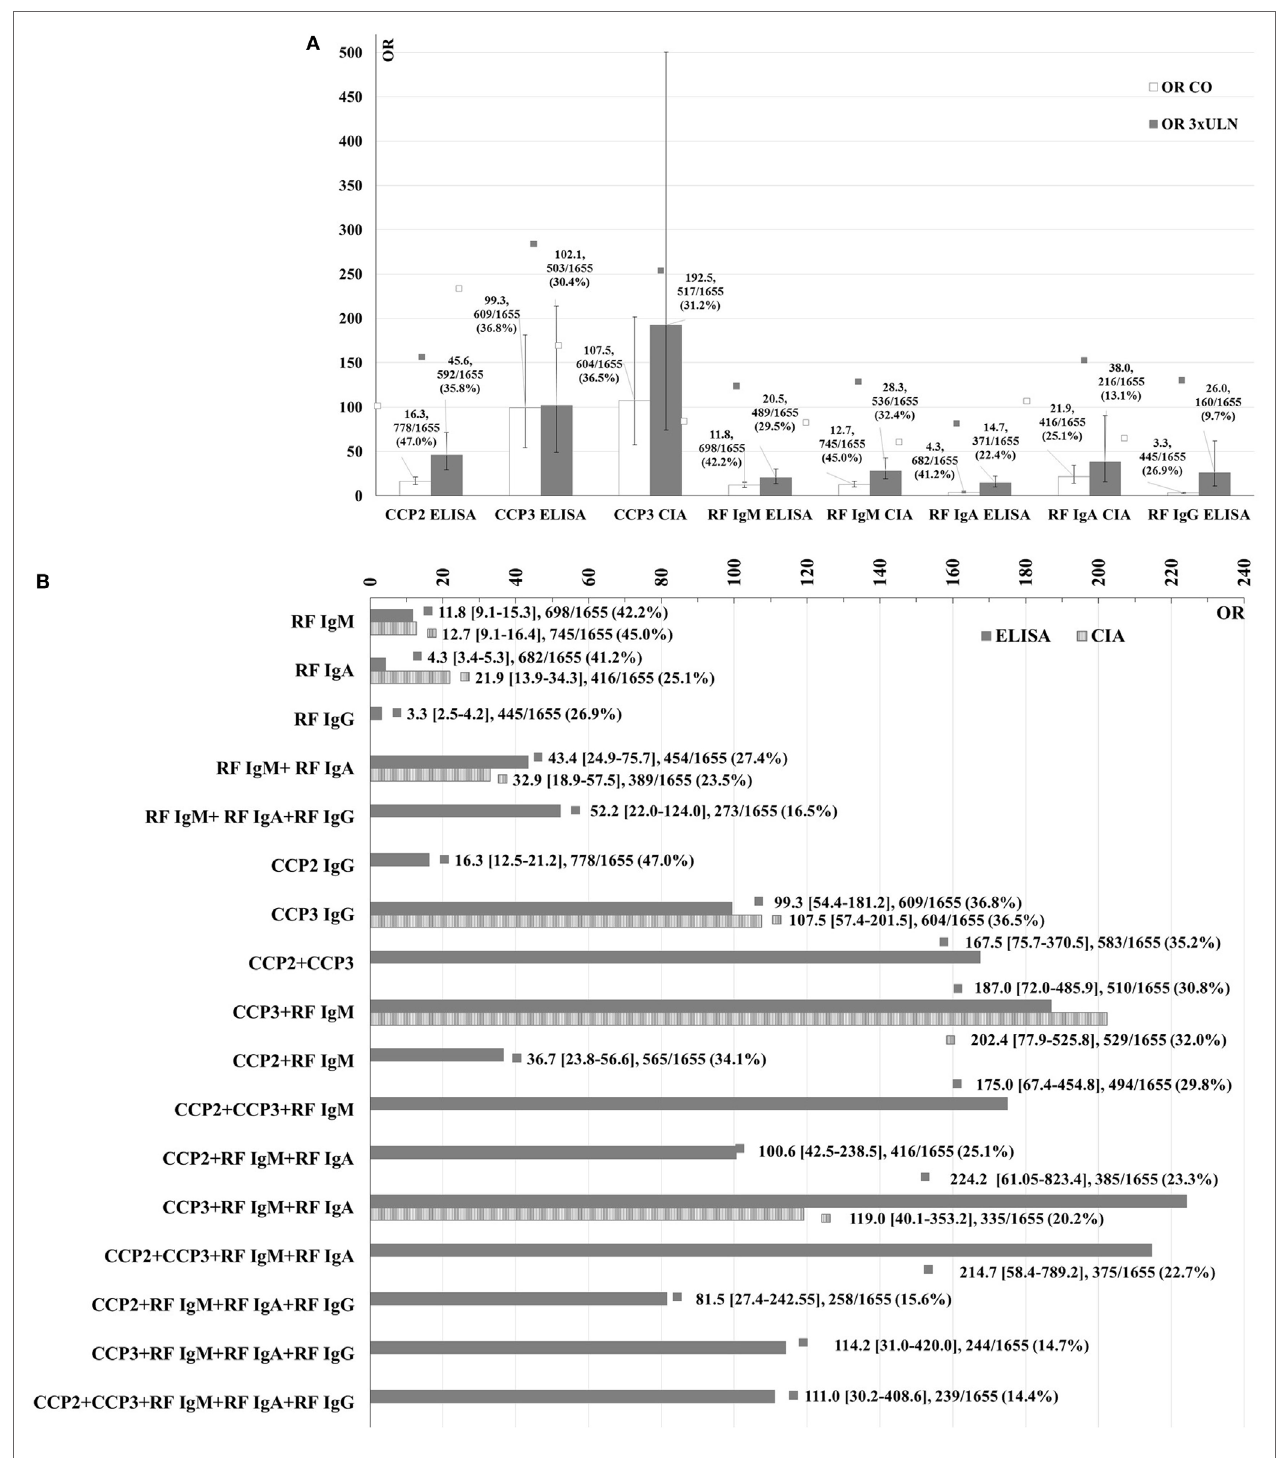
FigUre 1 | Association of single markers with RA [OR] on the ELISA and CIA platforms at the manufacturers cutoff or preliminary cutoffs for the research use only assays versus at the 3 × ULN (a) and association of single markers and combinations of markers with RA (OR) on ELISA (solid) and CIA (dashed) at the cutoffs (B) . OR values, 95% CI, number of patients positive for each condition, and % over the total number of patients included in the study are